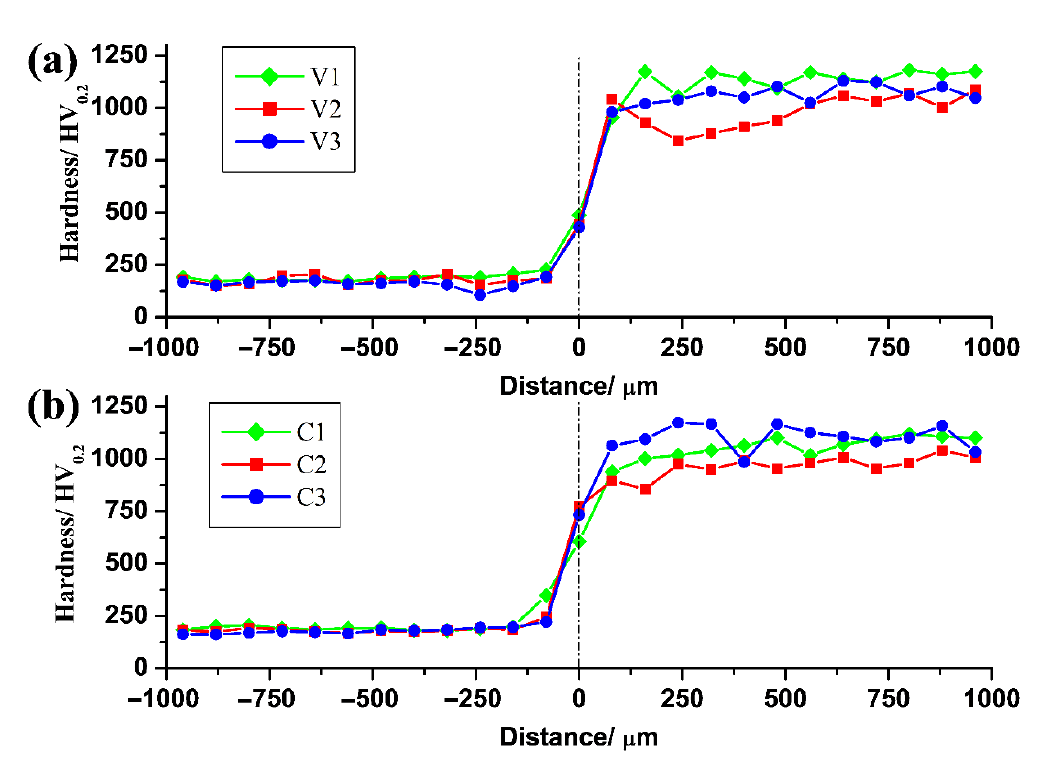
Figure 10. Microhardness distribution trend at the weld of the specimen ( a ) V1, V2, and V3. ( b ) C1, C2, and C3.